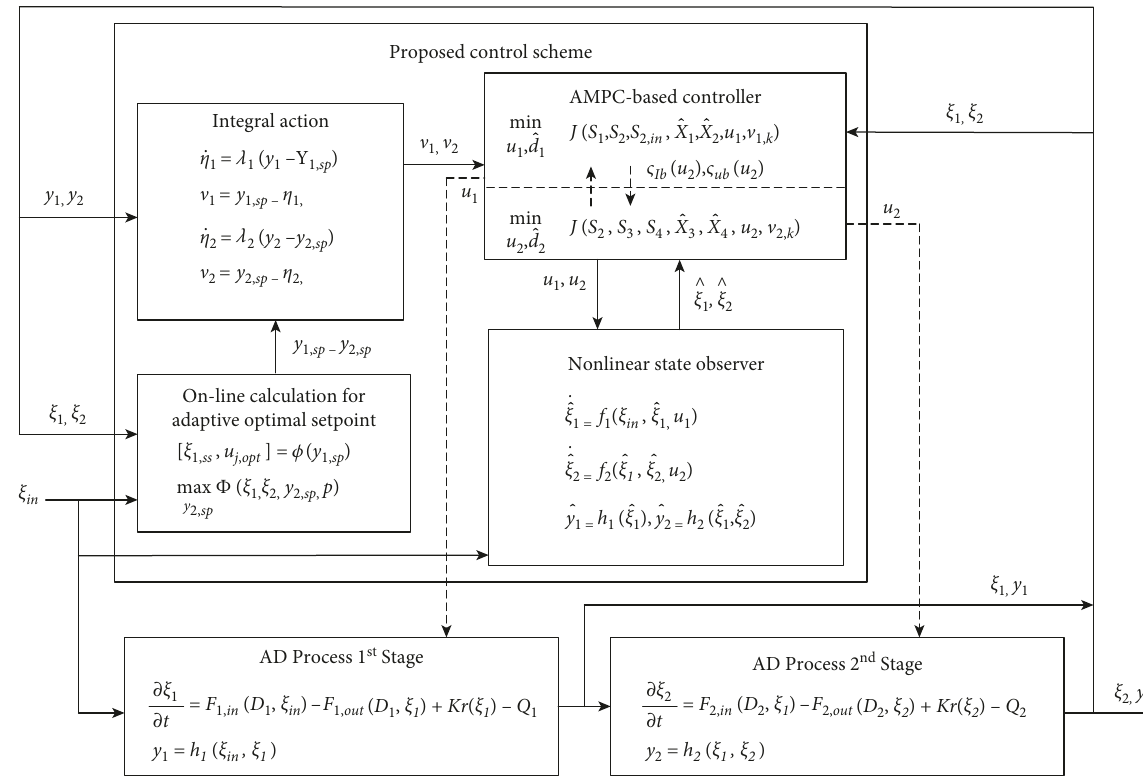
Figure 3: Schematic diagram of the proposed control scheme for the two-stage AD